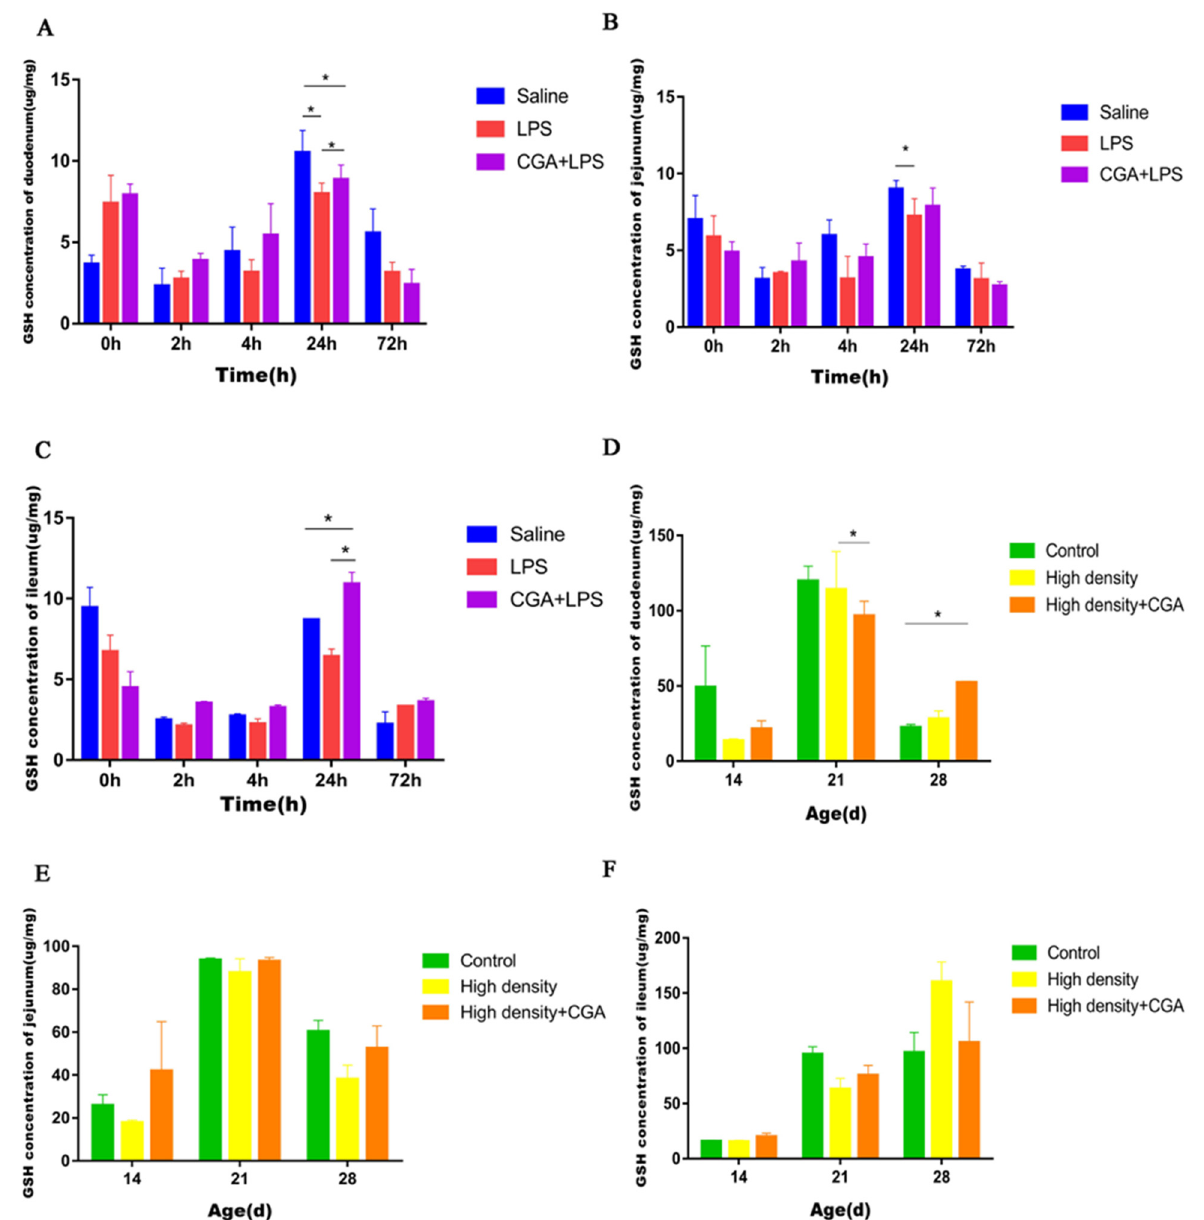
Figure 4. Effects of chlorogenic acid on intestinal glutathione levels of broilers challenged with immune stress and high density stress. ( A ) GSH levels of duodenum after immune stress. ( B ) GSH levels of jejunum after immune stress. ( C ) GSH levels of ileum after immune stress. ( D ) GSH levels of duodenum after high density stress. ( E ) GSH levels of jejunum after high density stress. ( F ) GSH levels of ileum challenged after high density stress. GSH = glutathione, * means significant difference between groups.